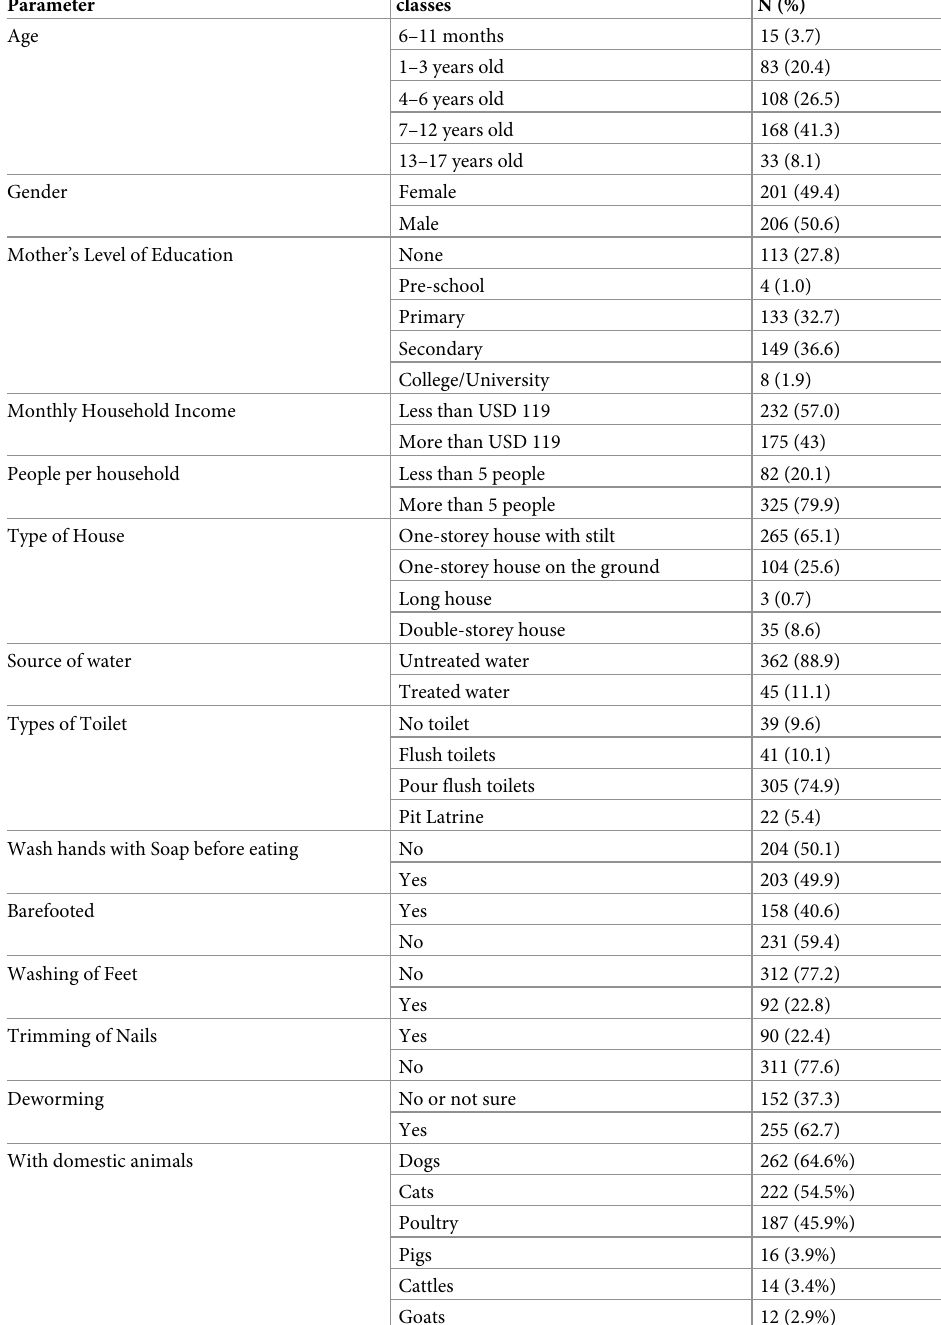
Table 2. Socio-demographic data of participants in this study. Total respondents =